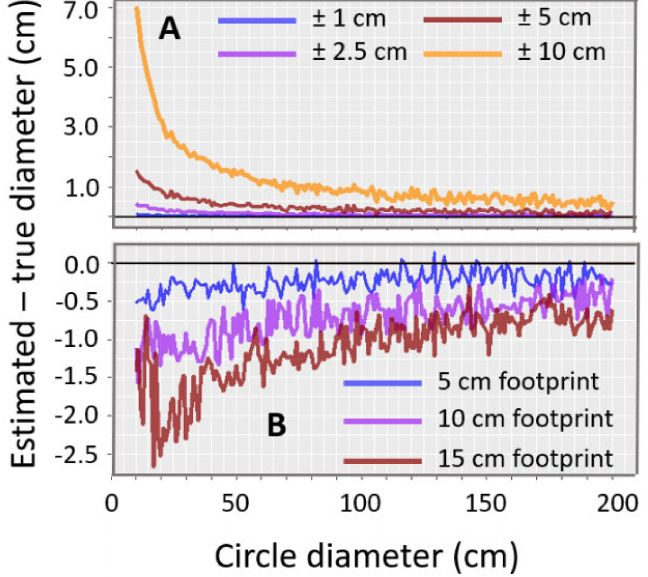
Figure 7. Simulated error in diameter estimates using the randomized Hough transformation. ( A ) Error in diameter due to random noise in simulated point locations under four noise levels (one sigma). ( B ) Error in diameter due to variation in footprint